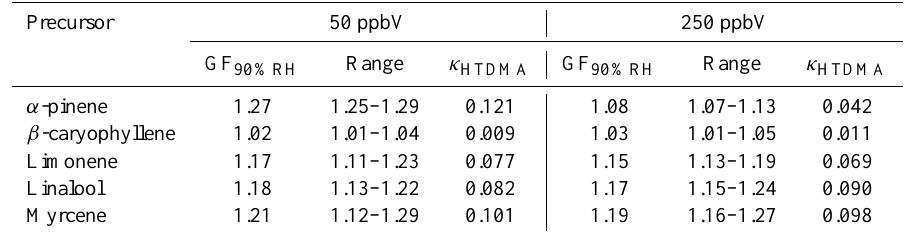
Table 3. Mean growth factor and κ values derived from the HTDMA measurements at 90% RH for the 50ppbV and 250ppbV initial precursor mixing